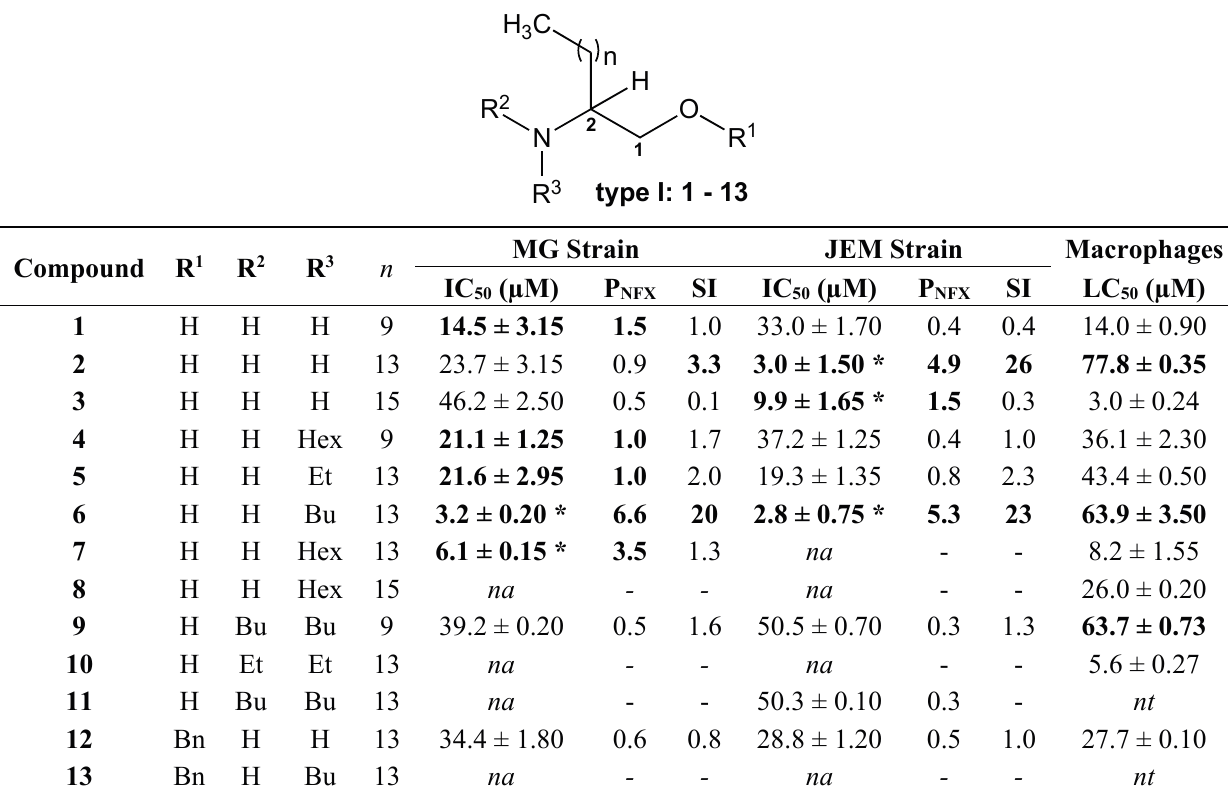
Table 1. In vitro activity of aminoalcohol derivatives against epimastigotes of two strains of Trypanosoma cruzi